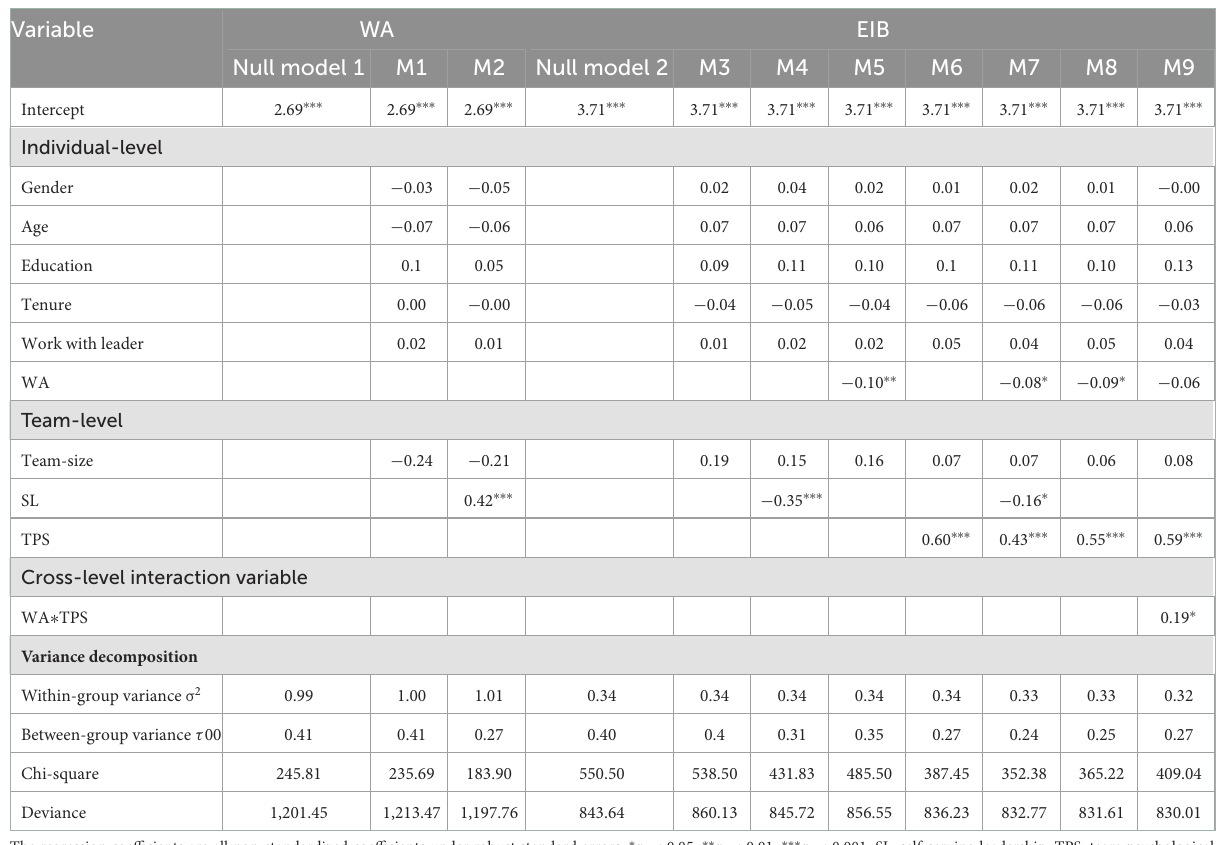
TABLE 4 HLM results for hypothesis